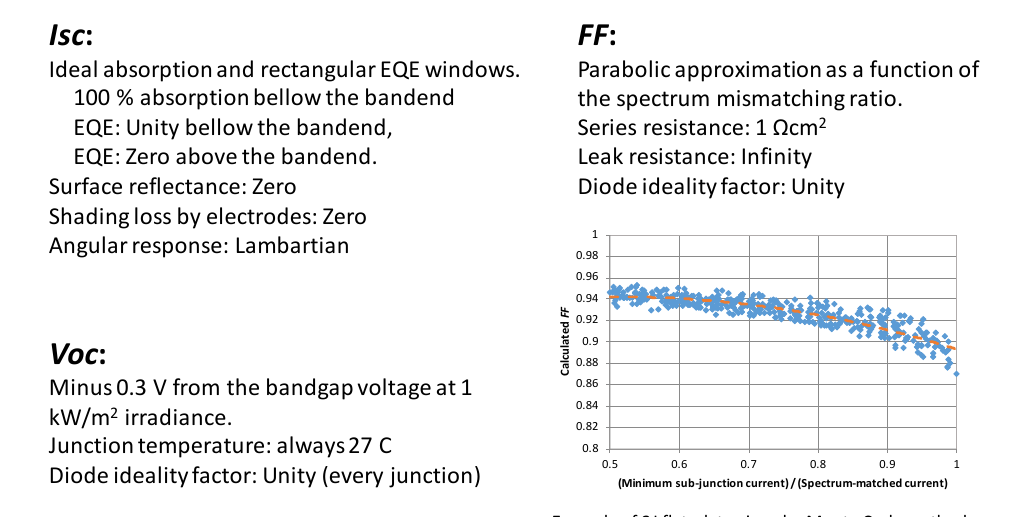
Figure 3. Diagram of how the output power of solar cells is calculated (composed of three factors).